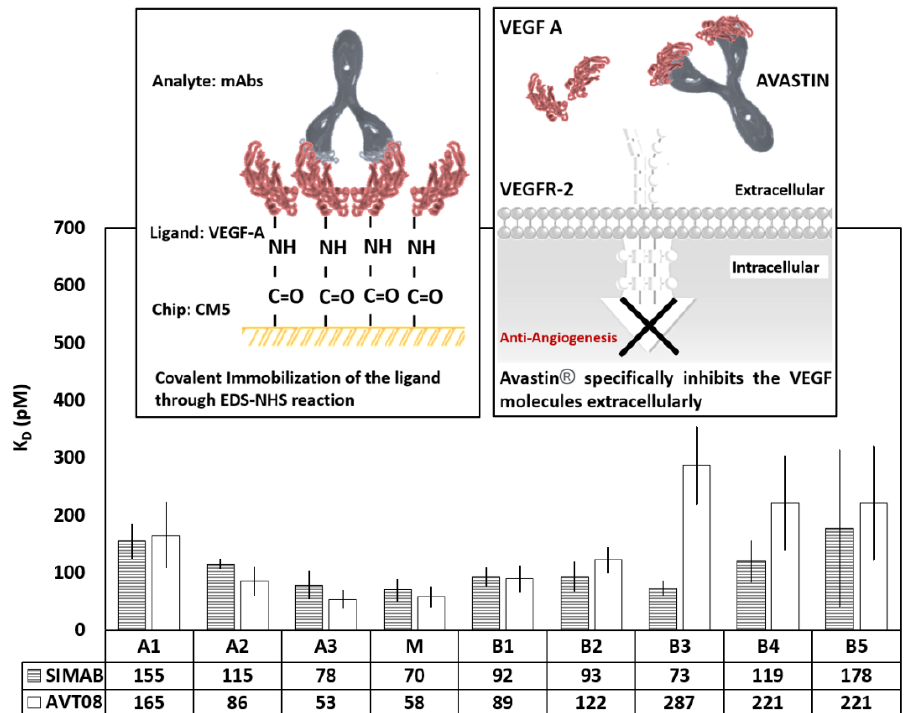
Figure 5. The VEGF-binding characteristics of the fractionated charge variants using the SPR using the Langmuir 1:1 binding model. The samples fractionated by the CEX method were obtained from the innovator (AVT) and the biosimilar candidate (SIMAB054) under the same operational conditions. A, M, and B, respectively, represent acidic, main, and basic fractions. The K D data were presented as the mean value obtained from at least five measurements. The inset (top-left) is a representative illustration of the prepared SPR chip surface. The inset (top-right) shows the proposed mechanism of action for Avastin ® , adapted from reference